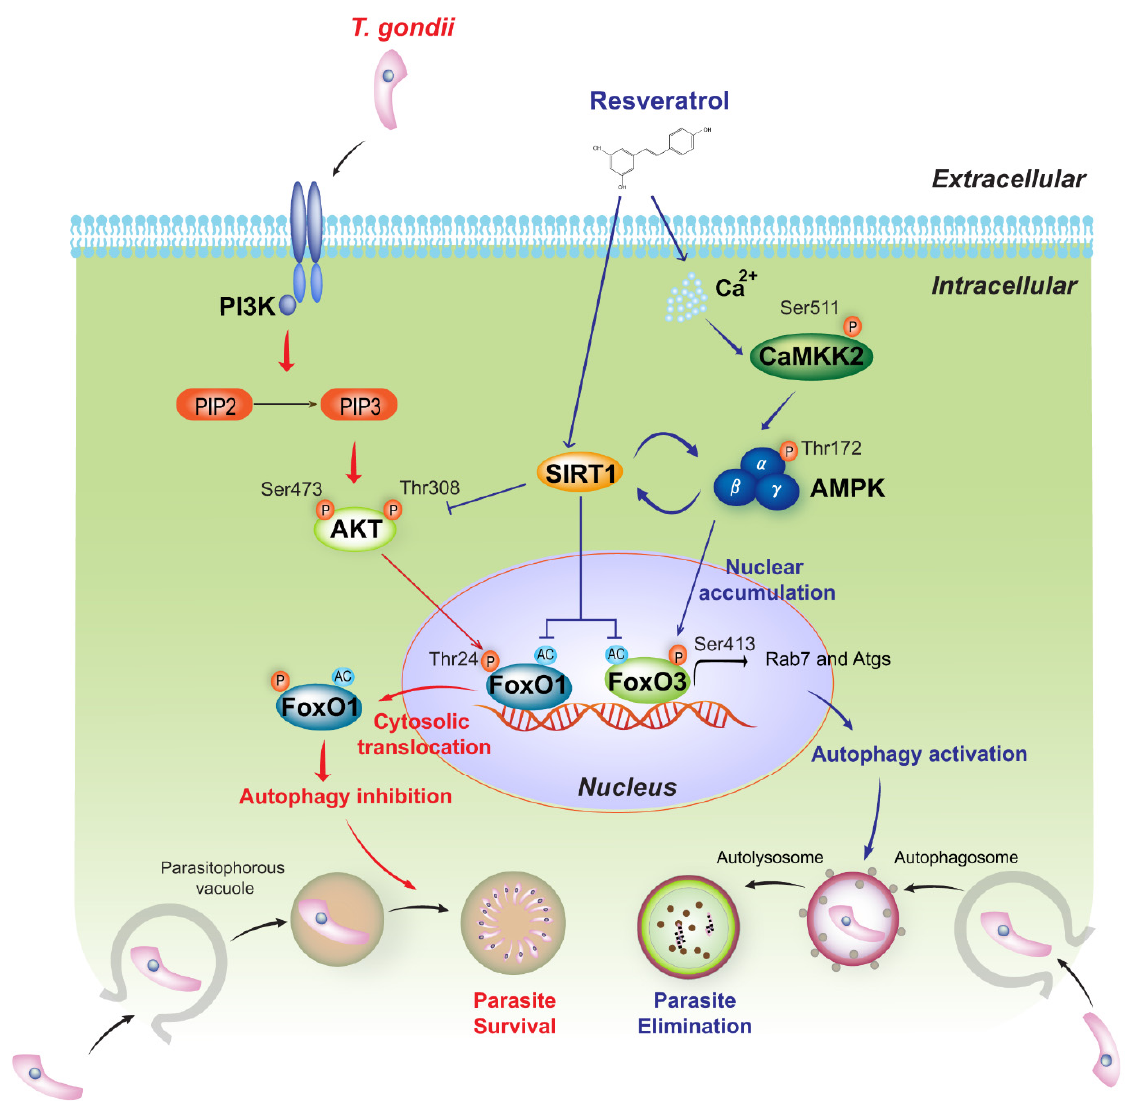
Figure 7. Essential function and molecular mechanism of SIRT1 in modulating the host immune response to T. gondii infection. In macrophages, myeloid-specific SIRT1 increases autophagy activ- ity during T. gondii infection, thereby eliminating intracellular T. gondii by inducing the colocalisa- tion of parasitophorous vacuoles with autophagosomes/lysosomes. As a key regulatory mecha- nism of autophagy, SIRT1 attenuates the acetylation of the transcription factor FoxO1 and its PI3K/AKT-dependent phosphorylation (Thr24) in response to T. gondii , thus regulating FoxO1 transactivation activity by preventing its nuclear exclusion. Moreover, SIRT1 promotes FoxO3a deacetylation and its CaMKK2/AMPK-dependent phosphorylation (Ser413), leading to nuclear accumulation and the transactivation of FoxO3a. Pharmacological activation of SIRT1 by RES in- duces antiprotozoal autophagy by regulating FoxO1 and FoxO3a activity via the PI3K/AKT and CaMKK2/AMPK signalling pathways,